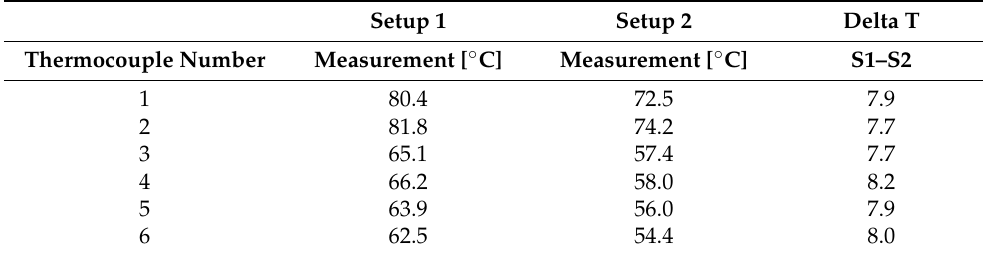
Table 6. Temperature measurements for Setup 1 and Setup 2.